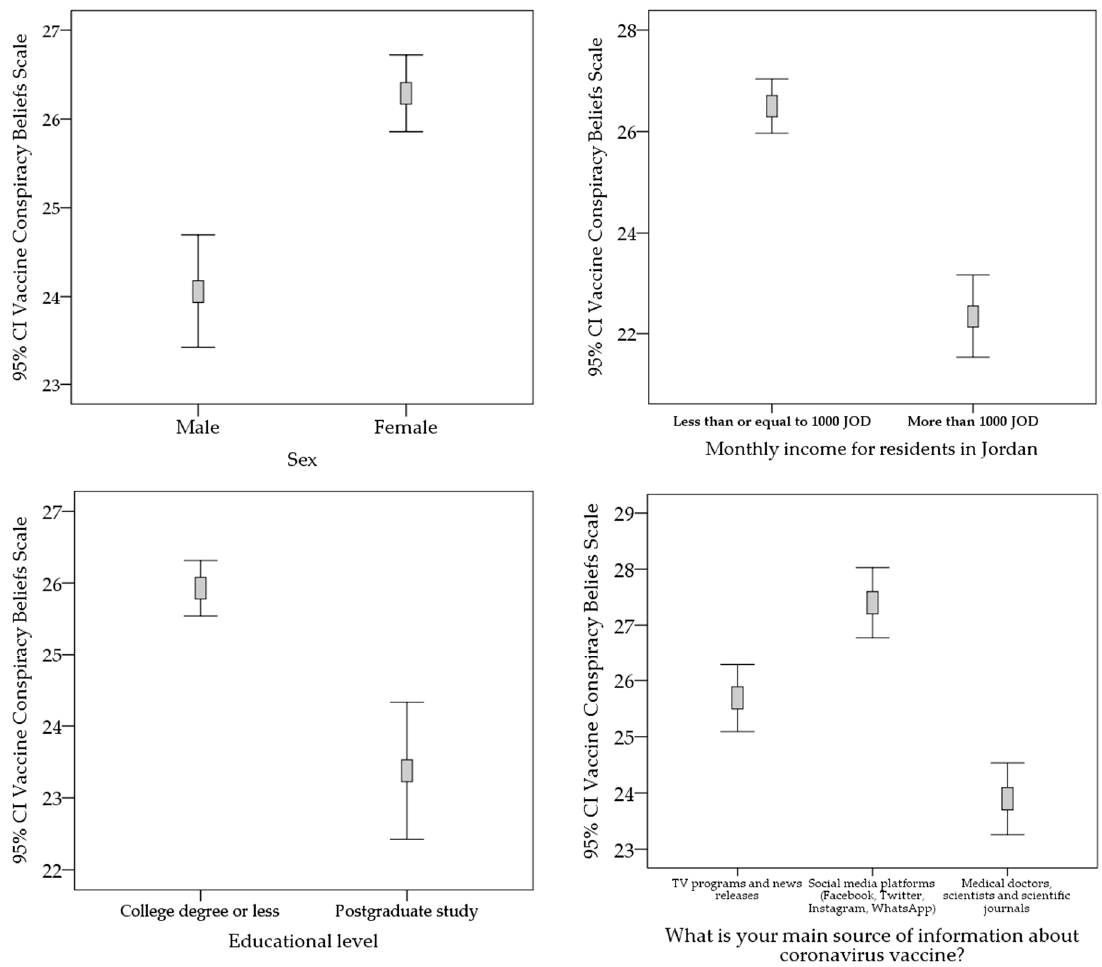
Figure 3. COVID-19 Vaccine Conspiracy Beliefs Scale correlation with sex, educational level and monthly income. CI: confidence interval of the mean; JOD: Jordanian dinar; monthly income was assessed only among respondents in Jordan.